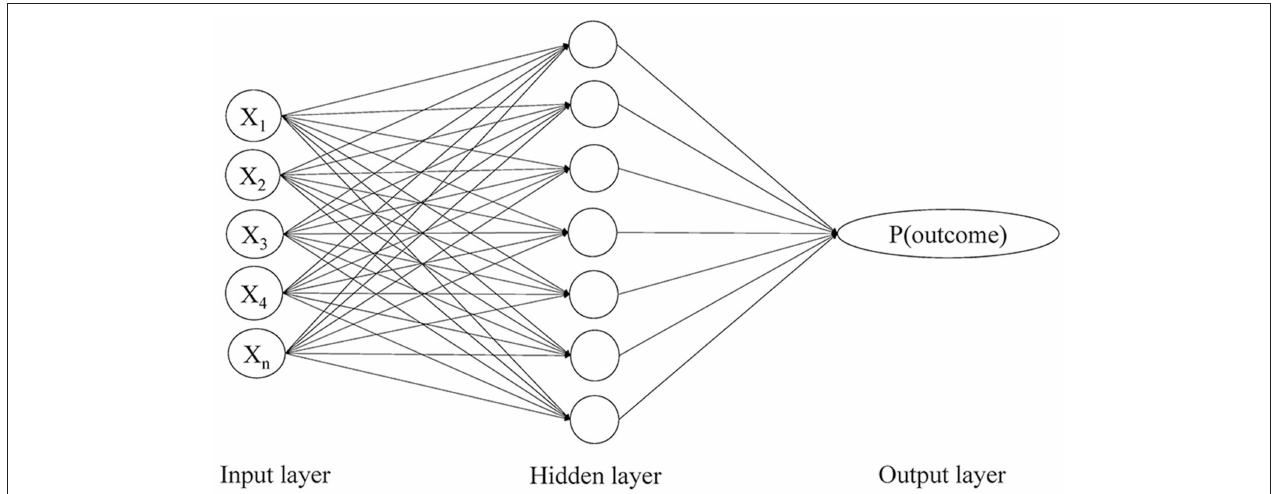
FIGURE 1 | The three-layer perceptron artificial neural network model showing input, hidden and output layers and nodes with feed forward links. P(outcome) refers to the probability of an outcome.